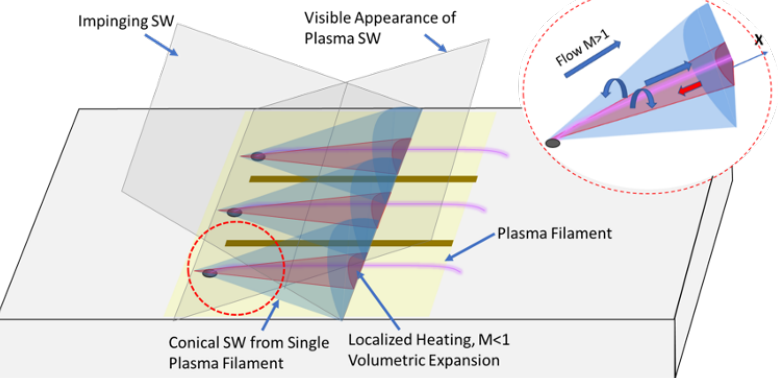
Figure 11. Illustration of SW-BL-plasma interaction